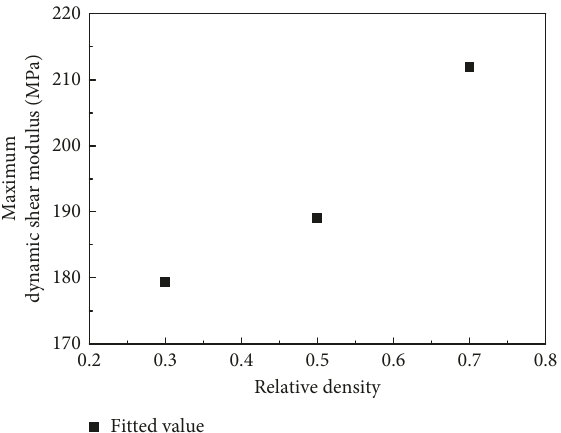
Figure 6: Relationship between the maximum dynamic shear modulus and relative density ( σ